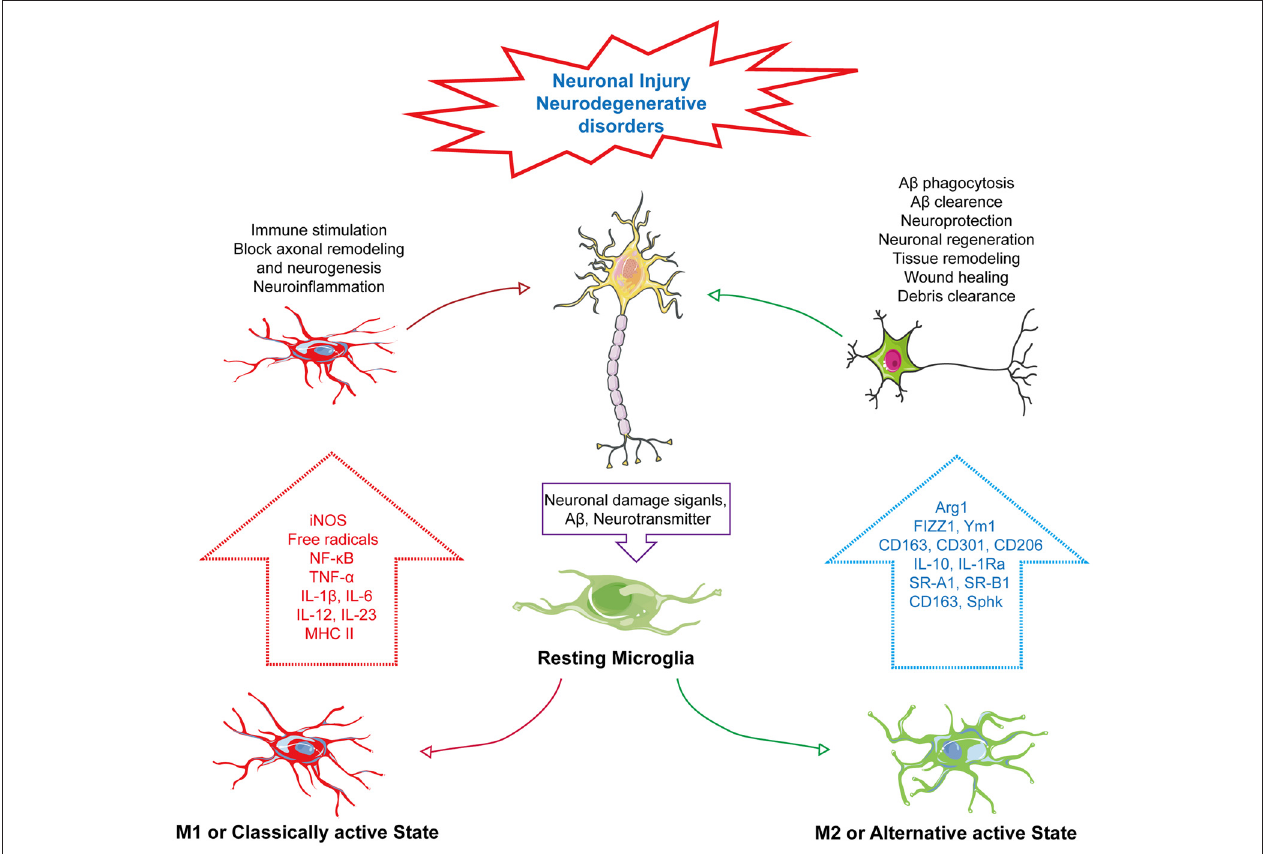
FIGURE 1 | Phenotype change of microglia in neurodegenerative disorders. In response to neuronal damage, signals mediated from neurons, such as neurotransmitter or amyloid- β (A β ), act as “on” or “off” signals for microglial activation. In response to “on” signals, there can be the alteration of its phenotype into two distinct states—M1: classically active state and M2: alternative active state. In the M1 state, microglia express iNOS and MHC II, activating the NF- κ B pathway to produce several pro-inflammatory cytokines, such as tumor necrosis factor- α (TNF- α ), IL-1 β , IL-6, IL-12 and IL-23, and generate ROS and NO, which subsequently induce immune stimulation, neuroinflammation, block of axonal remodeling and prevent neurogenesis. Unlike the M1 active state, the M2 or alternative active state mediate neuroprotection through A β phagocytosis and clearance, modulate neuronal regeneration, and releases arginase 1 (Arg1) for tissue remodeling, wound healing and debris clearance through releasing M2 markers, Arg1, found in inflammatory zone 1 (FIZZ1), chitinase-like protein 1 (Ym1), triggering receptor also expressed on myeloid cells (TREM), CD163, CD301, CD206 and IL-1 receptor antagonist (IL-1Ra) and also expressing other markers, such as scavenger receptor class A1 (SR-A1), scavenger receptor class B1 (SR-B1) and sphingosine kinase